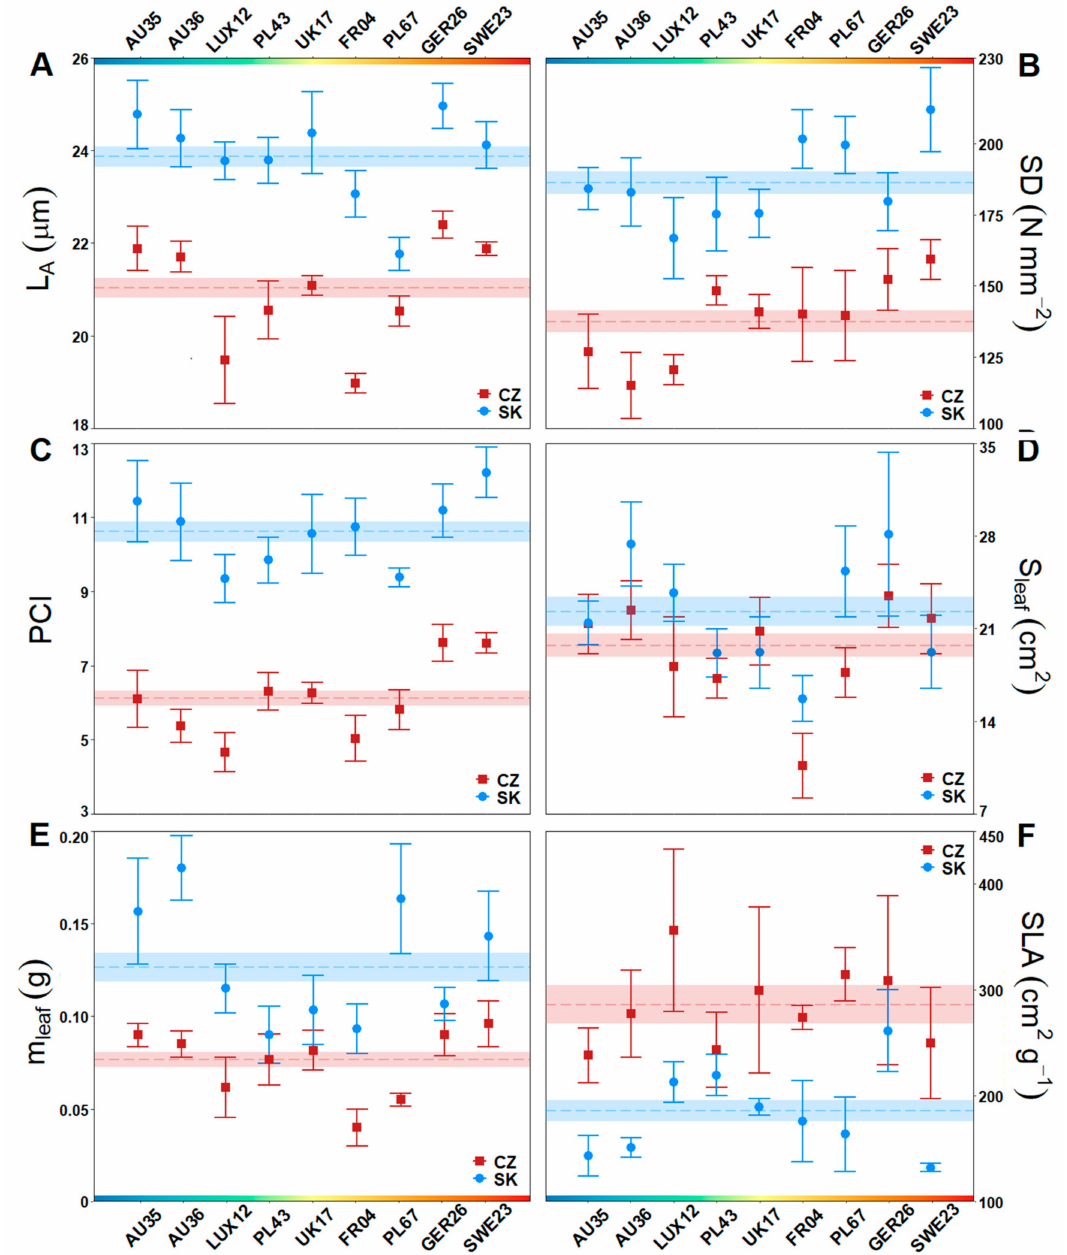
Figure 2. Mean values and standard errors of stomatal and leaf morphological traits per provenance: length of guard cell ( L A , ( A )), stomatal density ( SD , ( B )), potential conductance index ( PCI , ( C )), leaf size ( S leaf , ( D )), leaf dry weight ( m leaf , ( E )) and specific leaf area ( SLA , ( F )). The red colour represents provenances growing in the Czech provenance plot, and the blue colour represents provenances growing in the Slovak provenance plot. The dashed horizontal line represents the average per plot with the surrounding standard error interval band. Provenances are arranged based on the Ellenberg quotient of the original site (blue to red x axis